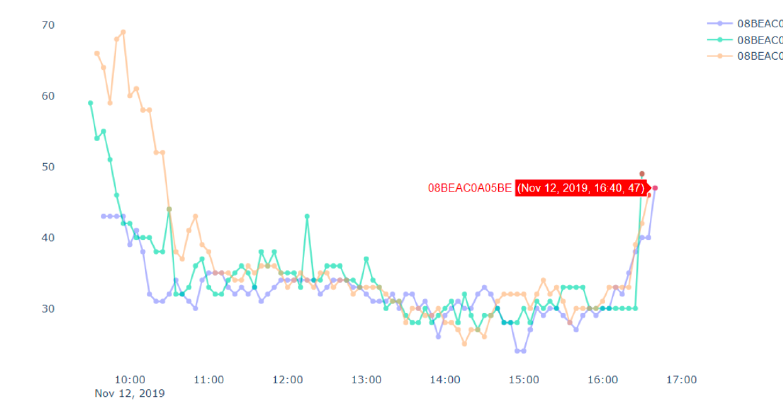
Figure 13. A case study on a fire event with PM2.5 sensors’ data—detected